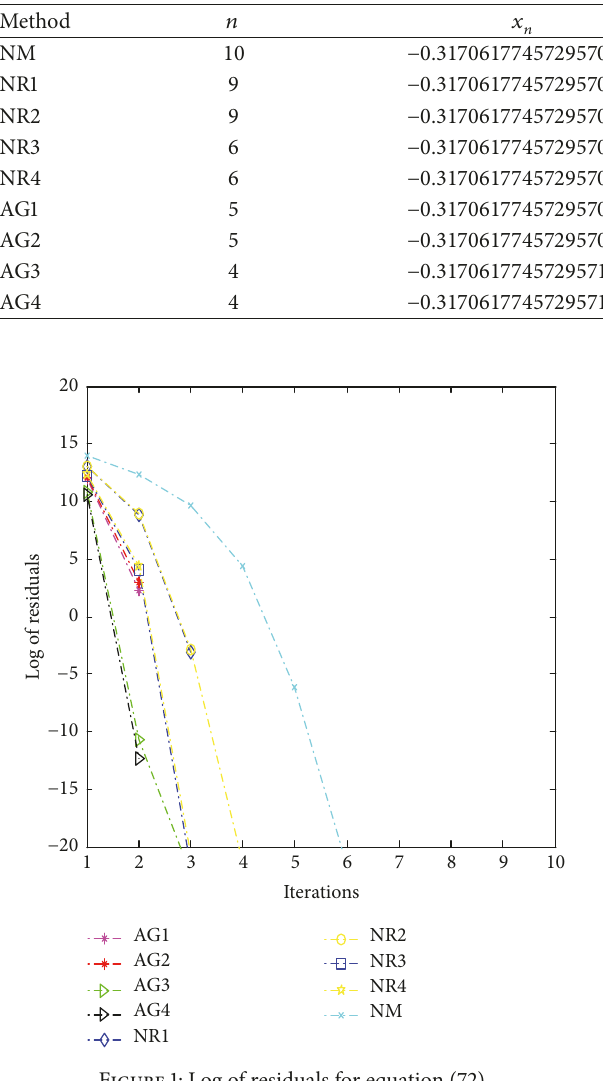
Figure 1: Log of residuals for equation